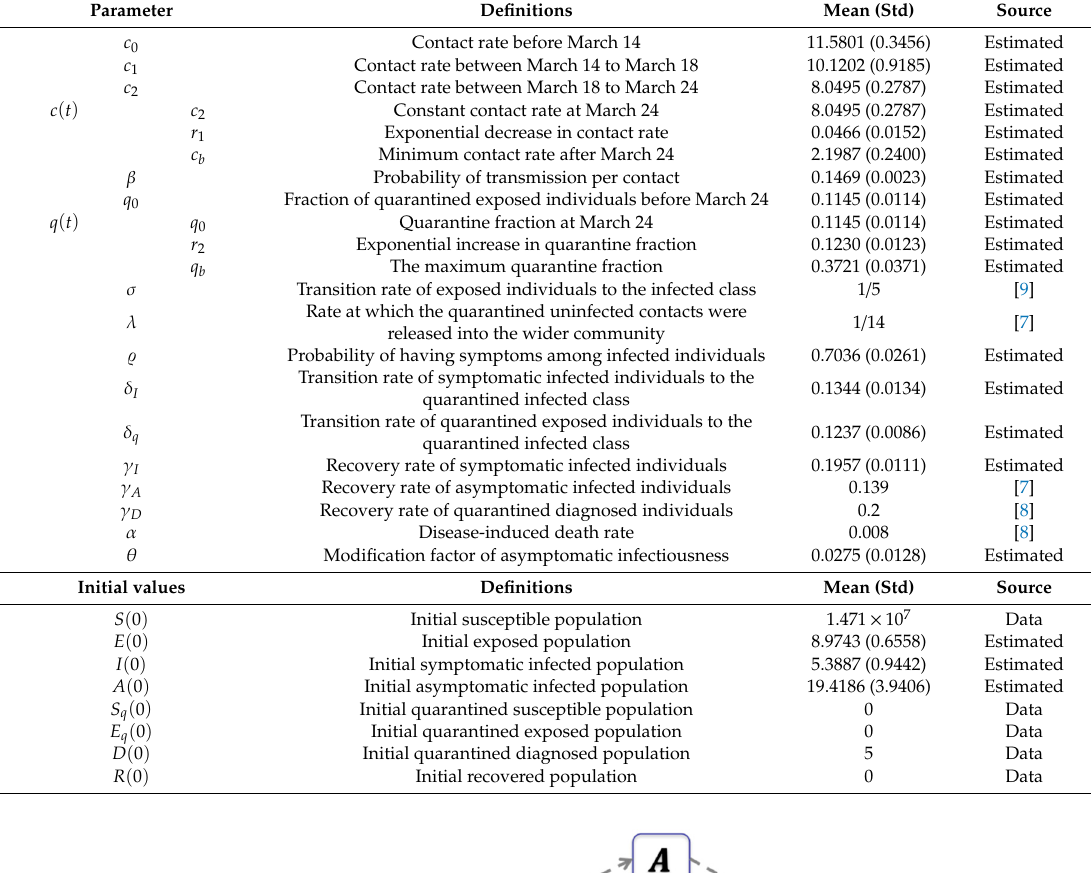
Table 2. Parameter estimates for COVID-19 in Ontario, Canada.